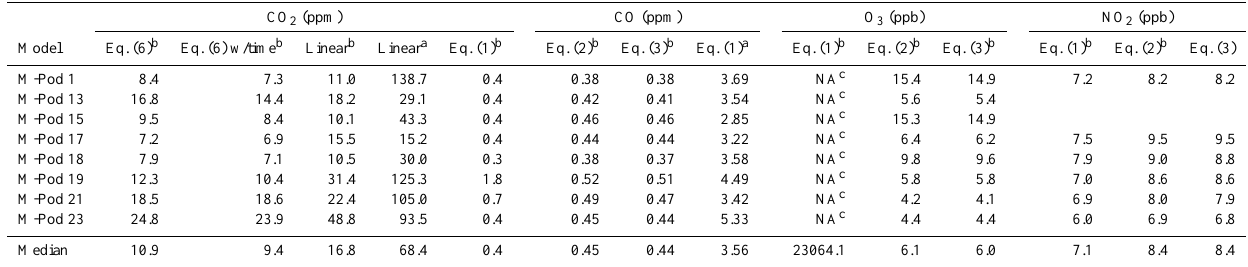
Table 2. Standard errors for the various calibration models tested with the December collocation data set. Equation (1), the exponential model, was not able to fit O 3 satisfactorily for some unknown reason. CO 2